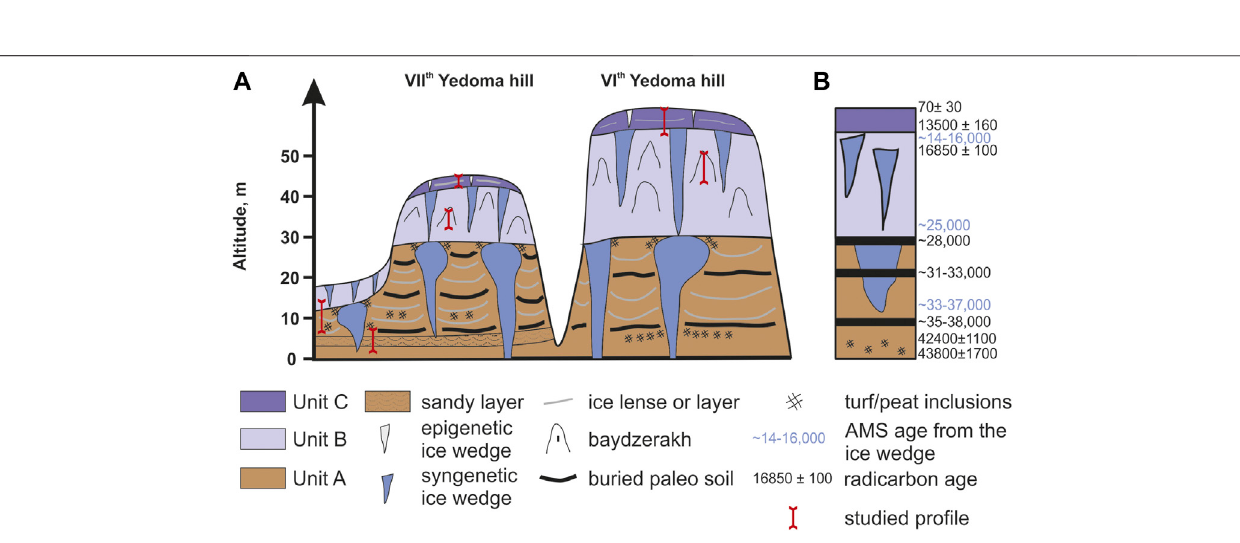
Frontiers in Earth Science |